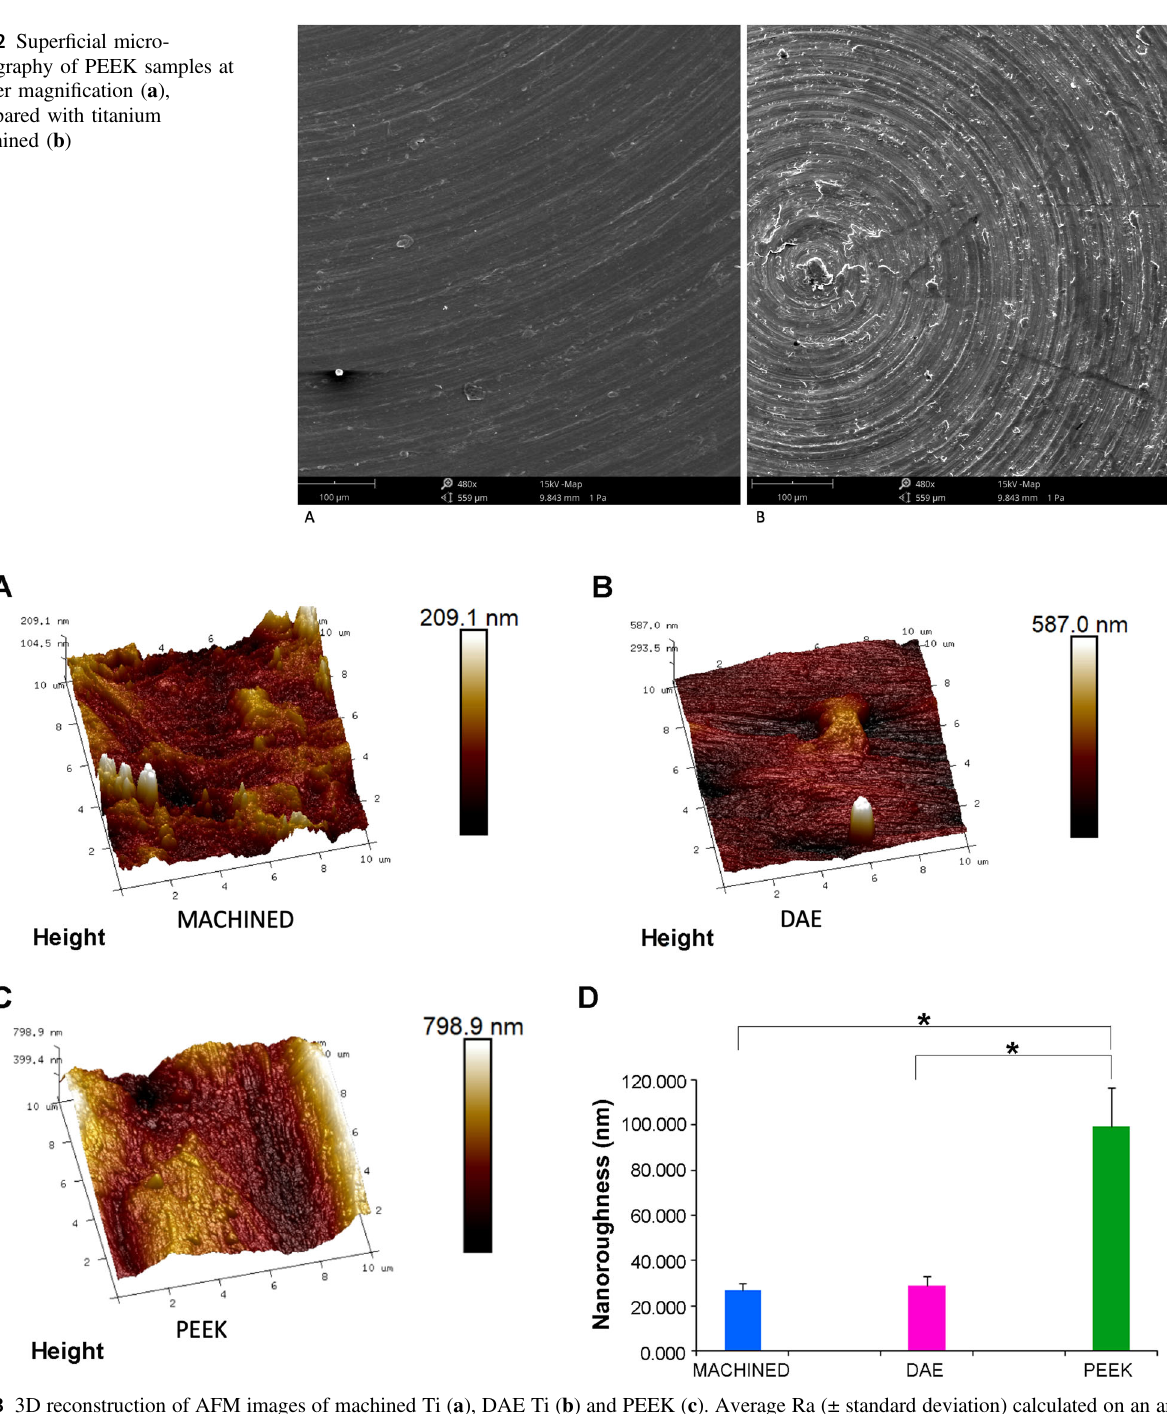
Fig. 3 3D reconstruction of AFM images of machined Ti ( a ), DAE Ti ( b ) and PEEK ( c ). Average Ra (± standard deviation) calculated on an area comprised between 10 μ m*10 μ m. Statistically signi fi cant differences (* p < 0.05) between PEEK and the other two groups ( d